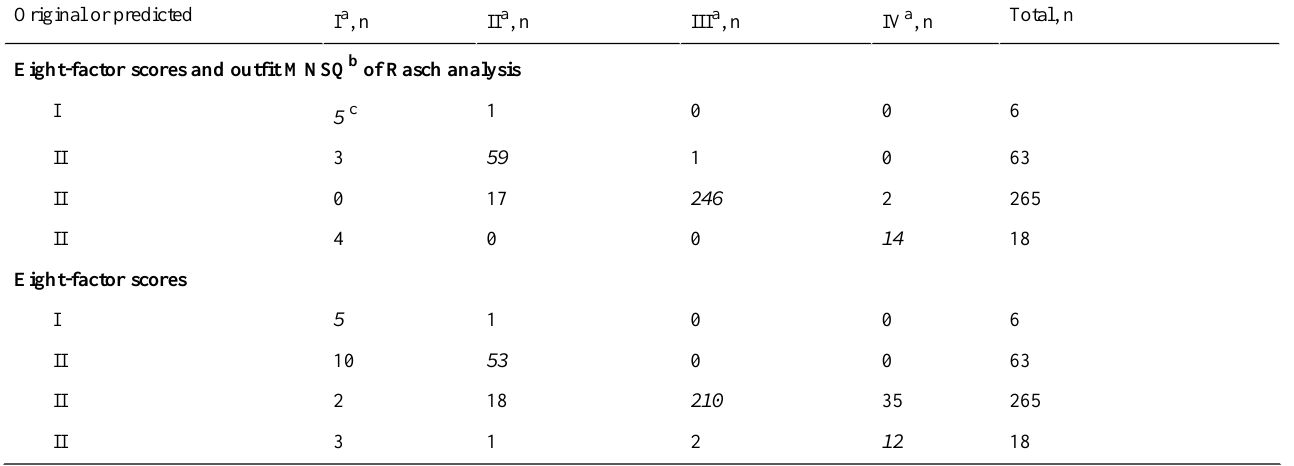
Table 3. Comparison of prediction accuracy using a different number of